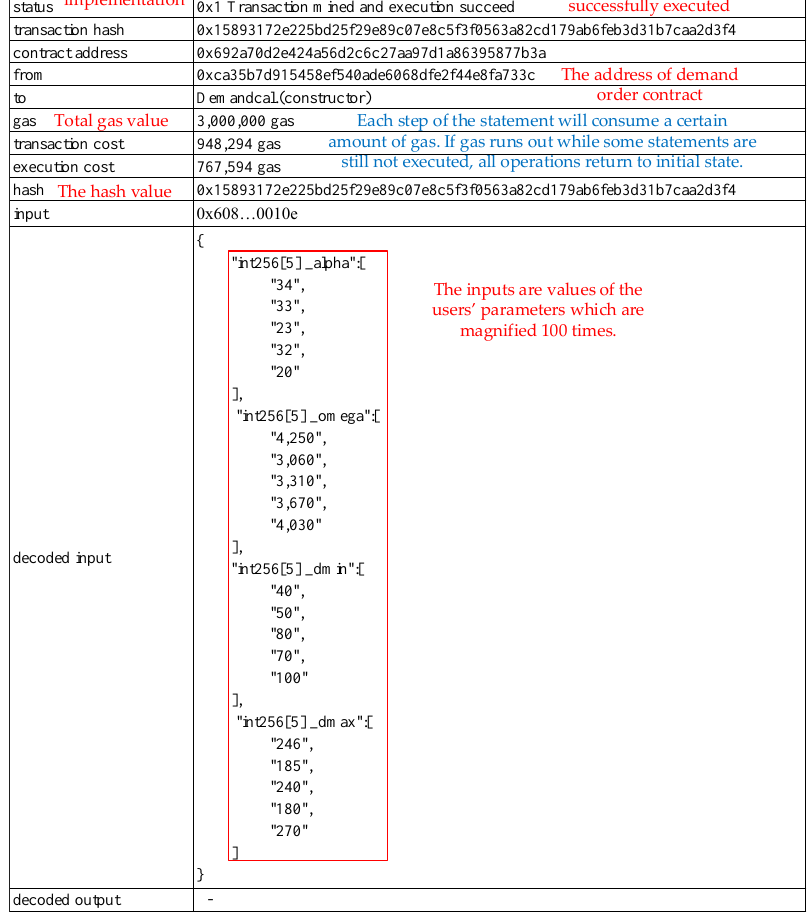
Figure 4. Buy ers’ demand value at the initial quoted price.